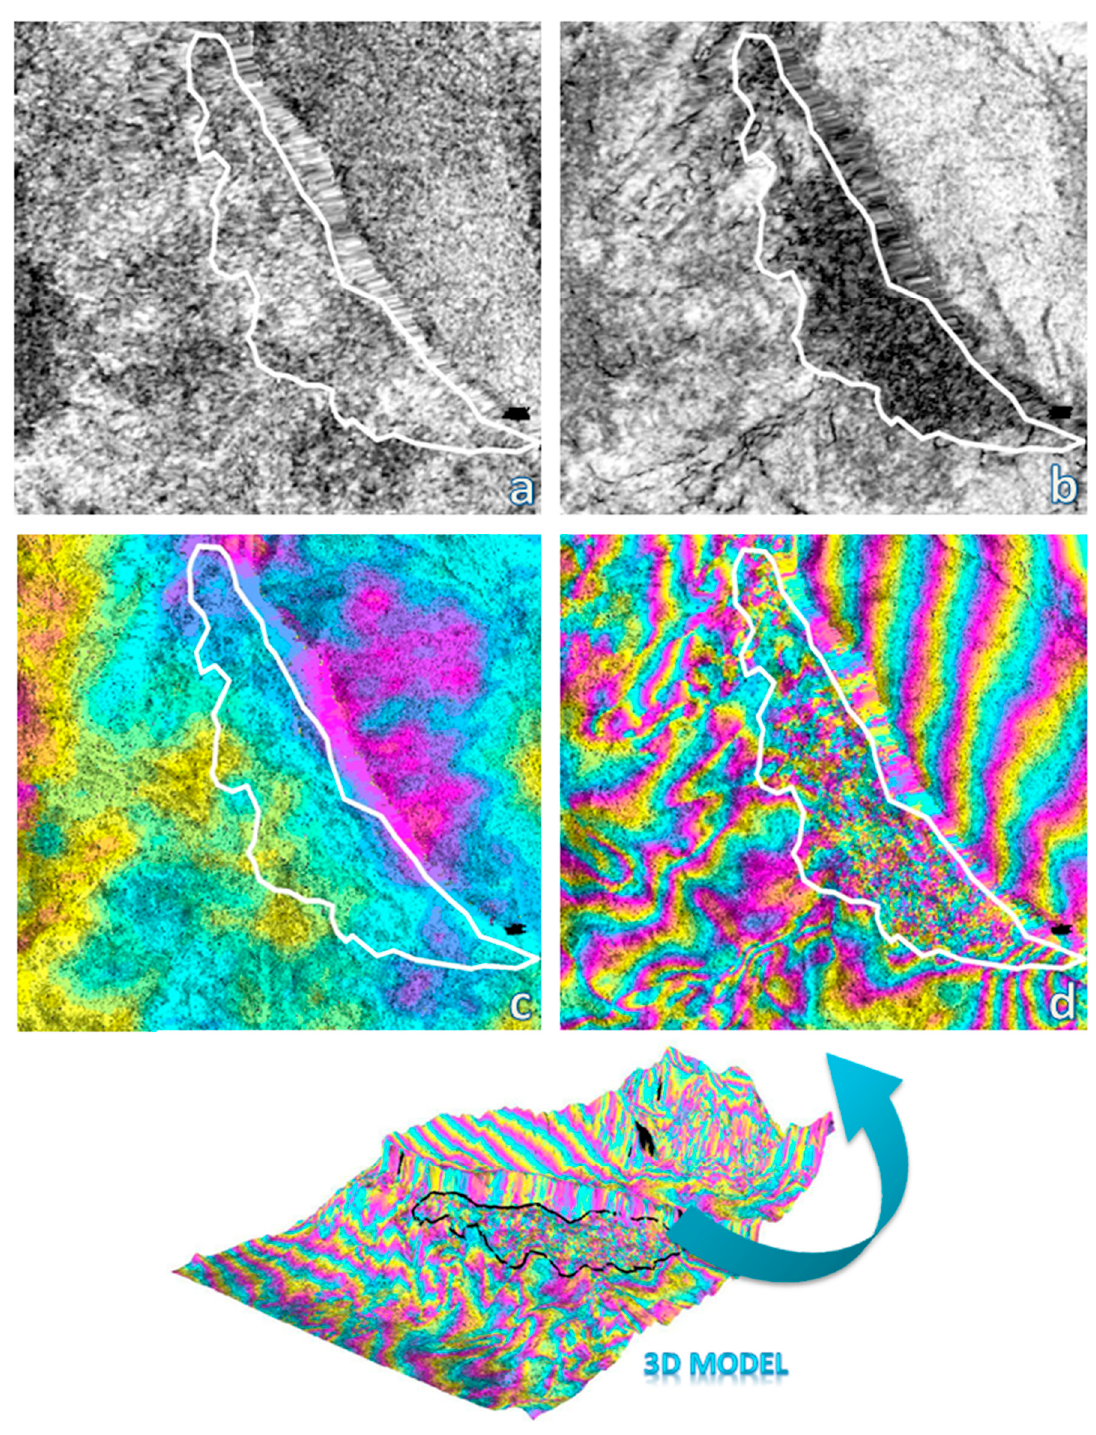
Figure 12. An enlarged landslide area based on ( a ) the coherence before, ( b ) the coherence after, ( c ) the interferogram before, and ( d ) the interferogram after the earthquake.